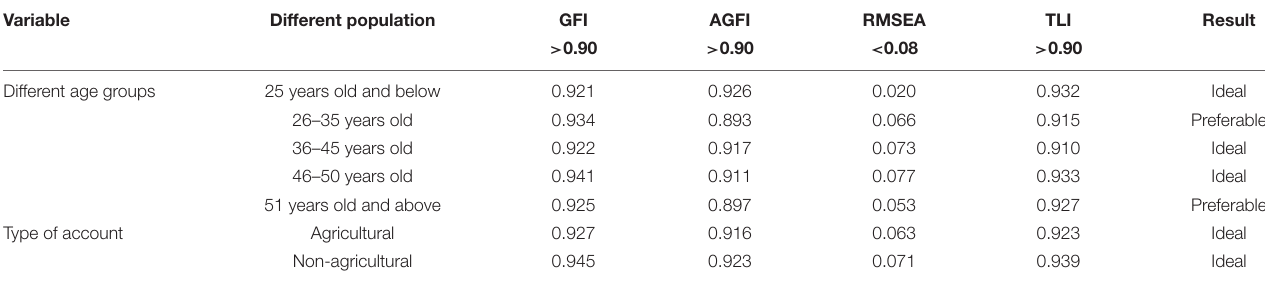
TABLE 7 | Comparison of parameters between different groups. Variable Different population GFI AGFI RMSEA TLI Result > 0.90